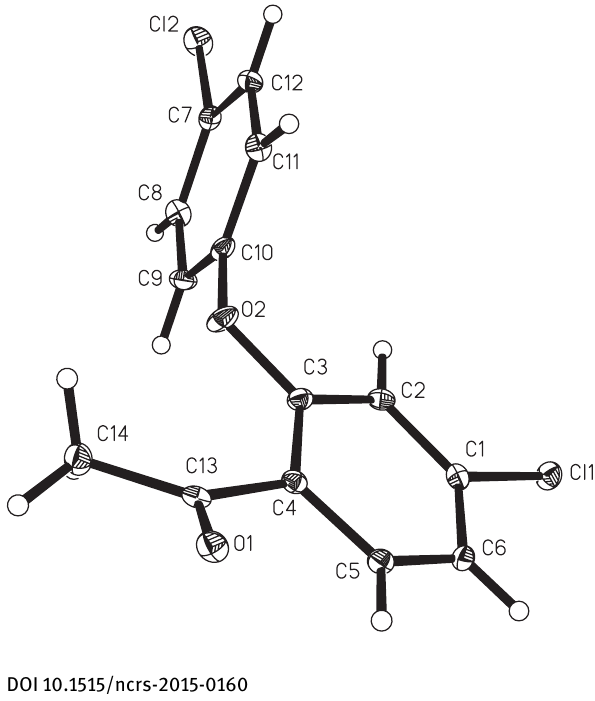
Table 1: Data collection and handling.